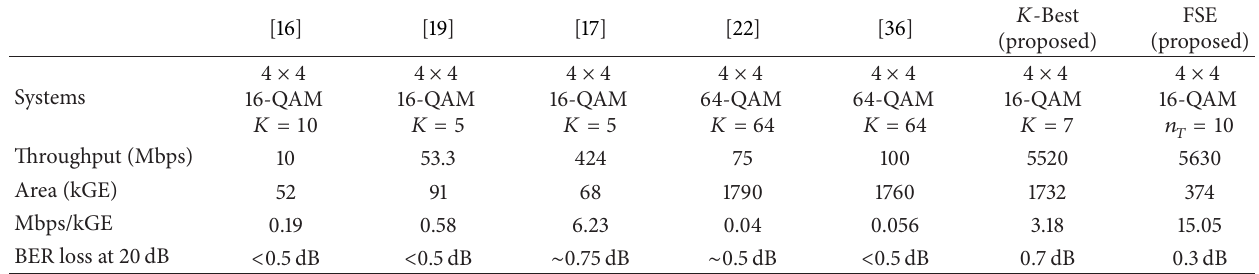
Table 2: Throughput, area occupation and BER loss with respect to the optimum for the 𝐾 -Best applied to MIMO detection and the proposed 𝐾 -Best and FSE approaches for